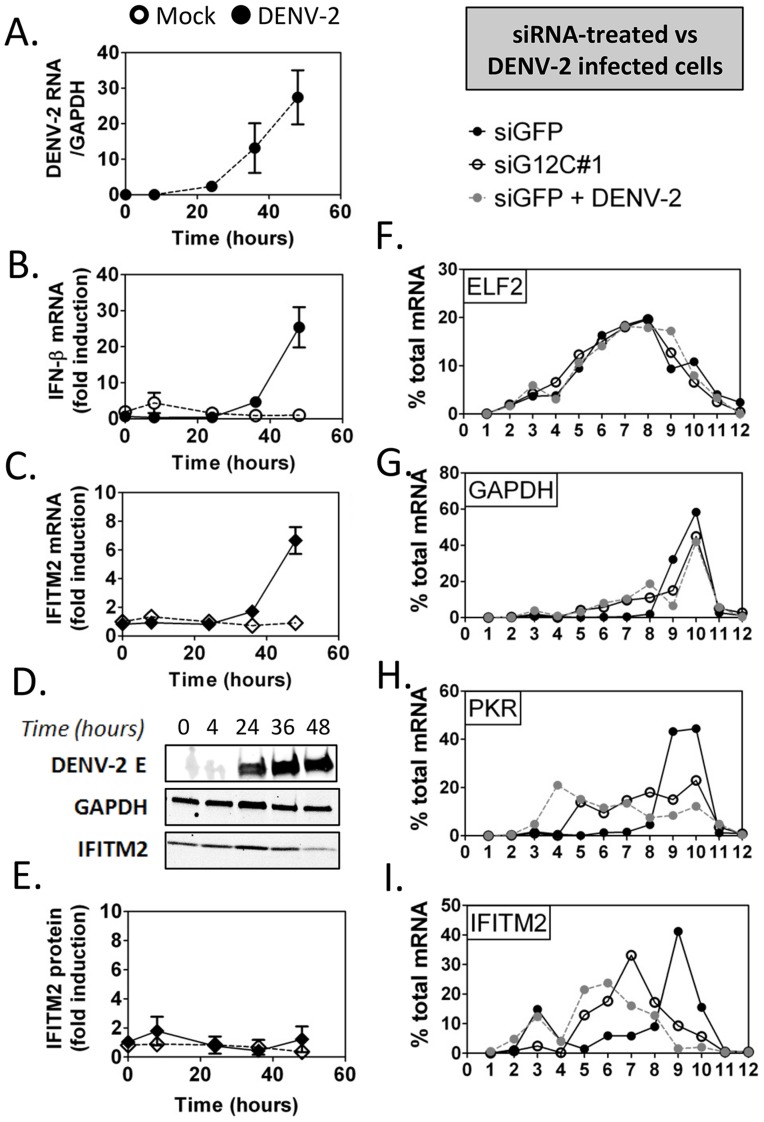
DENV-2 infection interferes with ISG protein expression.HuH-7 cells were infected with DENV-2 at MOI = 1 and levels of viral products and host IFN response mediators were determined at the indicated times post infection as described above. (A–C) DENV-2 genomic RNA and IFN-β and IFITM2 mRNAs were measured by quantitative real-time RT-PCR and normalized to GAPDH mRNA levels. (D–E) DENV-2 Envelope protein (E) and IFITM2 were detected by western blot and quantified by analysis of fluorescence intensity relative to GAPDH. Open symbols represent mock-infected cells and solid black or grey symbols DENV-2 infected cells for each time-course. (F–I) Control HuH-7 cells (siGFP, black), siG12C-treated (siG12C#1, open) or infected with DENV-2 at MOI = 1 for 24 h (siGFP + DENV-2, grey) and treated with 100 UI/ml IFN-β for 4 h were subjected to polyribosome fractionation. Percentage of ELF2, GAPDH, IFITM2 and PKR mRNAs across fractions was determined by quantitative real-time RT-PCR.